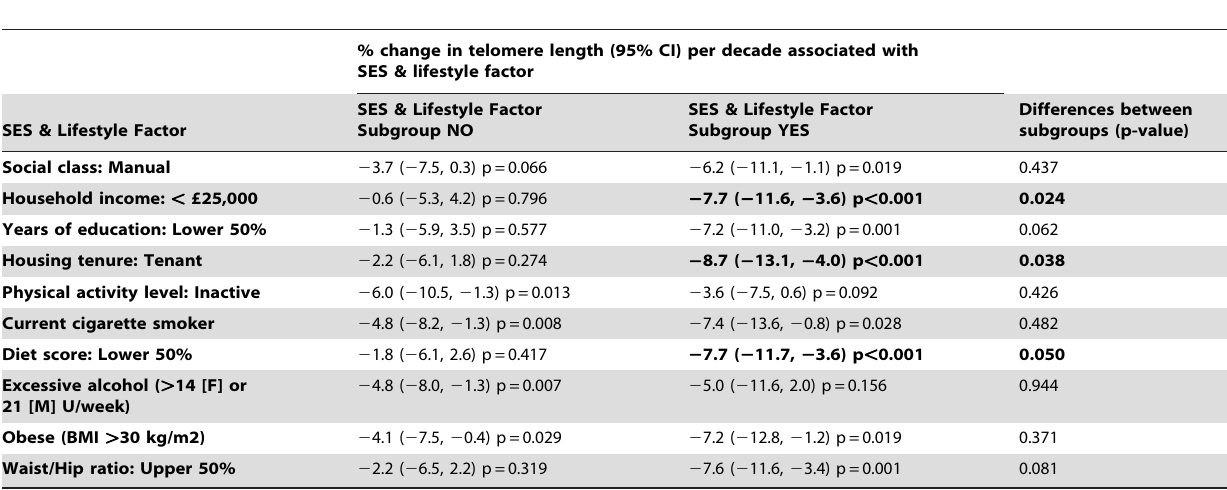
Table 1. Highlights the percentage change in telomere length per decade that is associated with SES and lifestyle